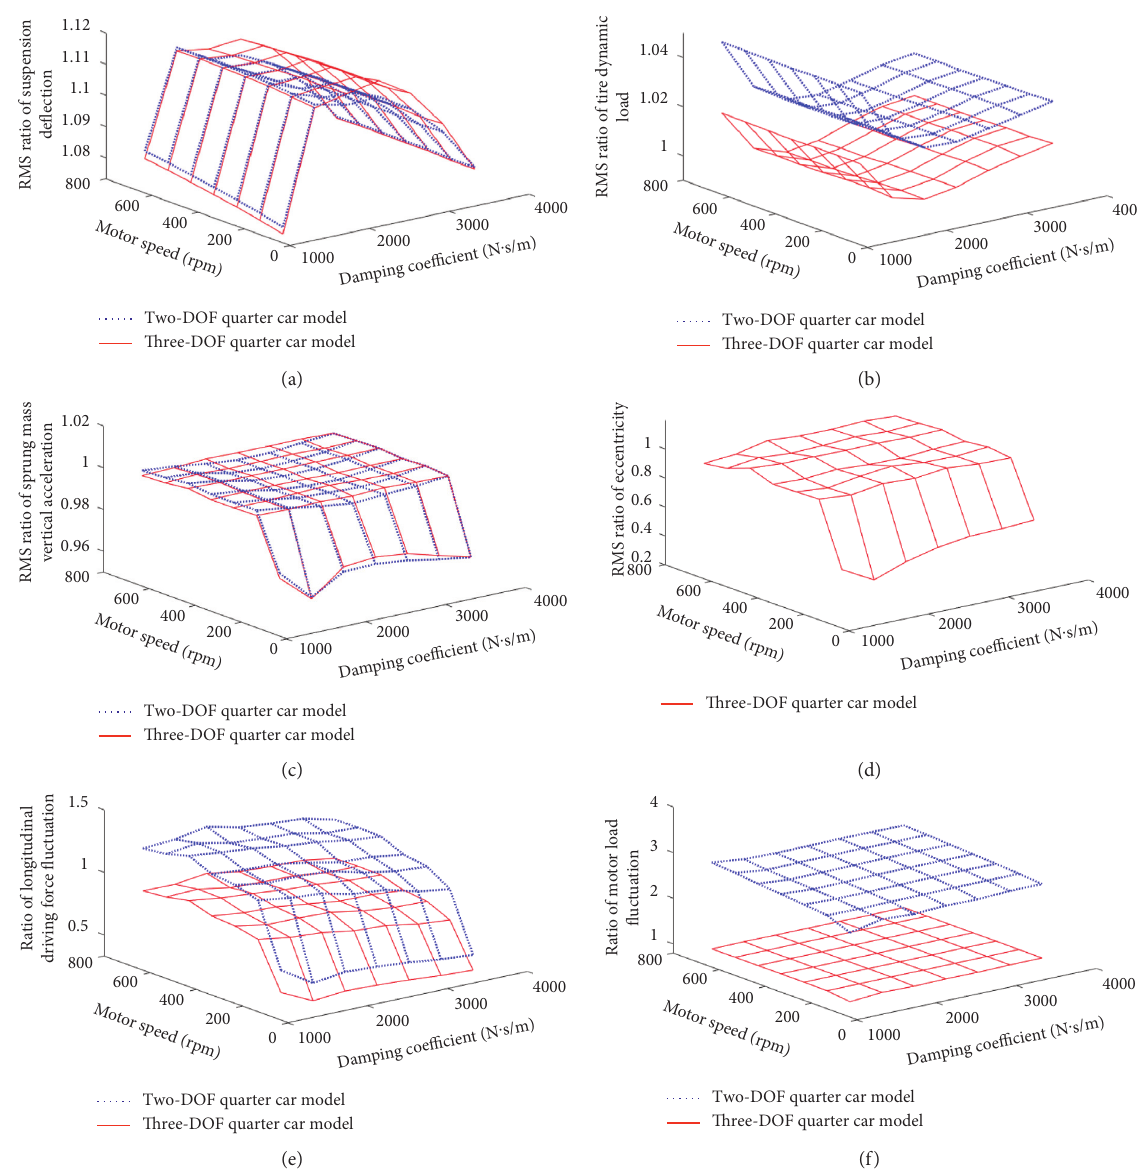
Figure 14: Ratio of RMS and fluctuation of evaluation indices between traditional quarter car models and HDD-AS system model. (a) RMS of suspension deflection. (b) RMS of tire dynamic load. (c) RMS of sprung mass vertical acceleration. (d) RMS of eccentricity. (e) Longitudinal driving force fluctuation. (f) Motor load